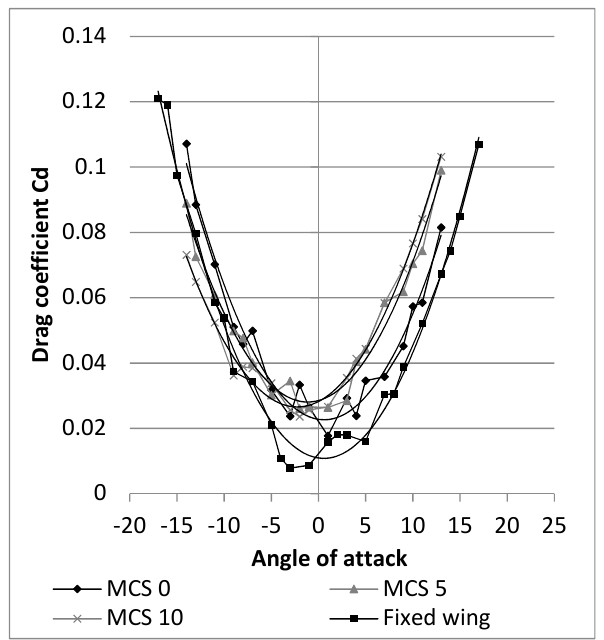
Figure 22. Induced drag coefficient 𝐶𝑑 (cid:3036) variation with the angle of attack.